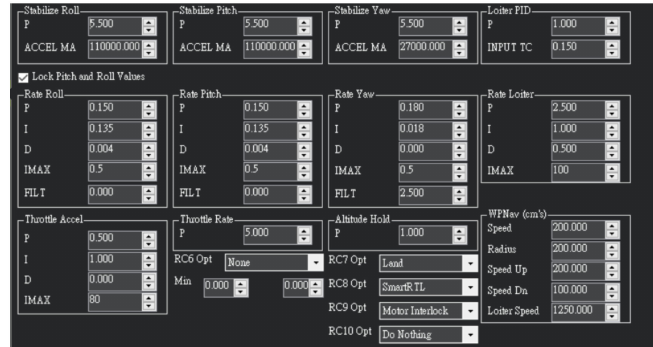
Figure 4. The proportional, integral, and derivative (PID) parameters of the